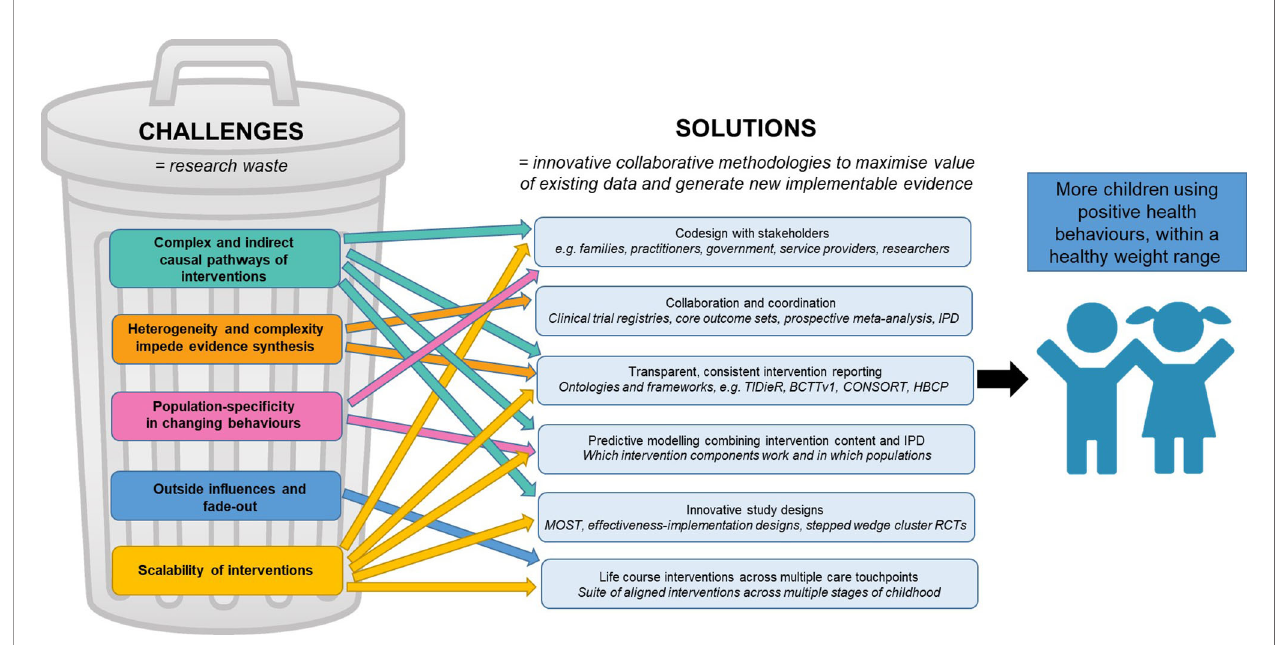
FIGURE 2 | Proposed solutions to challenges in early childhood obesity prevention interventions. Associations and interactions are hypothesised to be present between each of the challenges, as well as between each of the solutions. BCTTv1, Behaviour Change Technique Taxonomy version 1; CONSORT, Consolidated Standards of Reporting Trials; HBCP, Human Behaviour Change Project; IPD, individual participant data; MOST, Multiphase Optimisation Strategy; RCTs, randomised controlled trials; TIDieR, Template for Intervention Description and